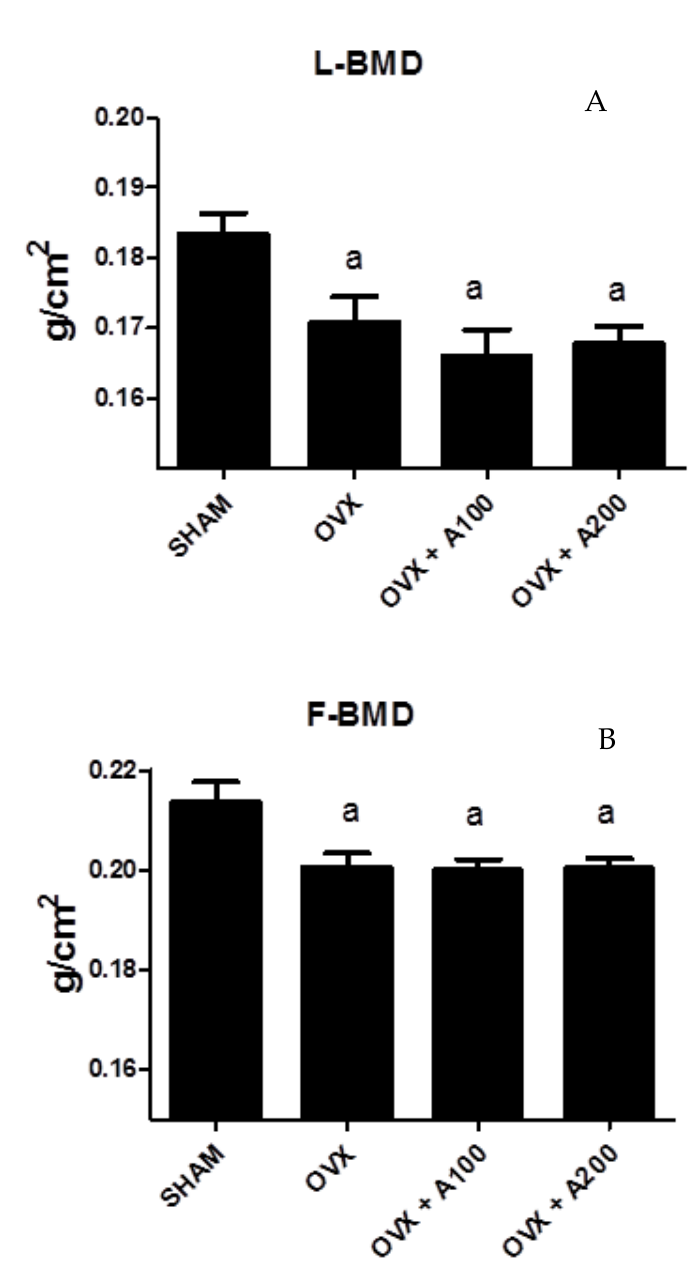
Figure 1. Lumbar bone mineral density (LBMD) ( A ) and femoral BMD (FBMD) ( B ) in a group of SHAM operated, ovariectomized (OVX), ovariectomized and treated with olive oil (OVX + 100) (100 µ L / day by oral gavage), and ovariectomized and treated with olive oil (OVX + 200) (200 µ L / day by oral gavage) over 3 months, n = 12. Data are expressed as mean ± SD. Statistical significance: ( a ) vs. SHAM. FBMD: OVX vs. SHAM p < 0.05, OVX + 100 vs. SHAM p < 0.05, OVX + 200 vs. SHAM p < 0.05. LBMD: OVX vs. SHAM p < 0.05, OVX + 100 vs. SHAM p < 0.01, OVX + 200 vs. SHAM p < 0.01.